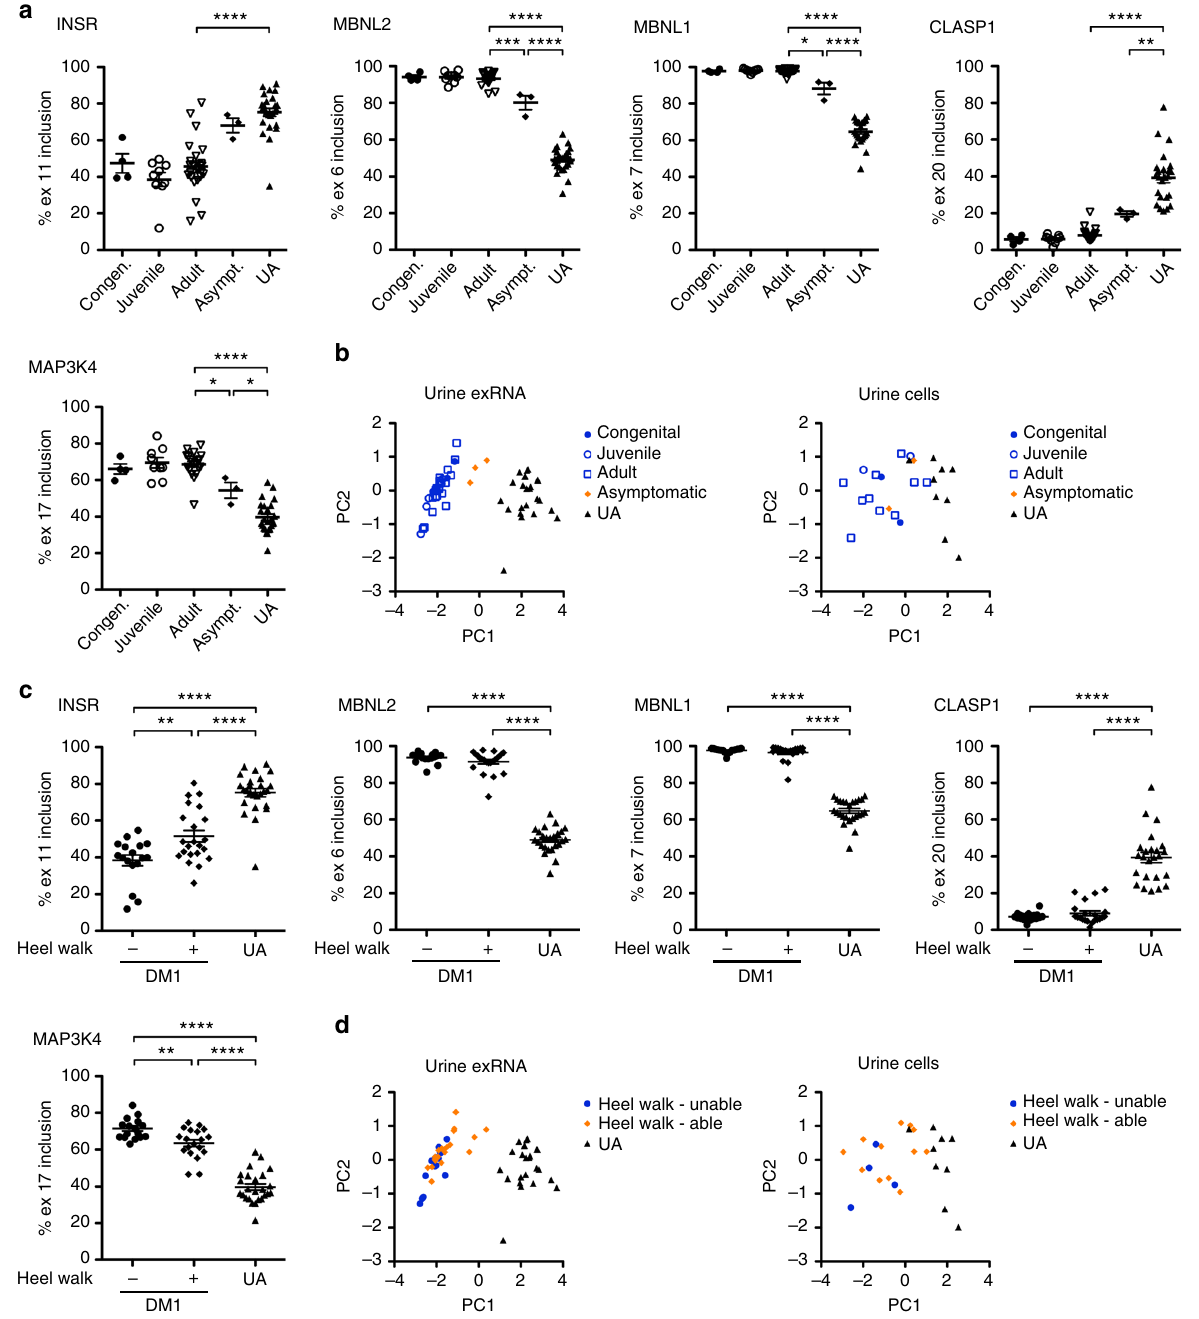
Fig. 9 Urine exRNA alternative splicing and composite biomarker scores as a function of symptoms. a ddPCR quanti fi cation of INSR , MBNL2 , MBNL1 , CLASP1 , and MAP3K4 alternative splicing in urine exRNA of congenital ( N = 4 or 5), juvenile-onset ( N = 6), adult-onset ( N = 22 to 24), and asymptomatic adult ( N = 3) DM1 patients, and in adult UA controls ( N = 25 or 26). **** P < 0.0001 (all fi ve transcripts, adult-onset vs. UA) and ( MBNL2 and MBNL1 , asymptomatic vs. UA,); *** mean difference 13.1, 95% CI of difference 4.3 – 22.0 ( MBNL2 , adult-onset vs. asymptomatic); ** mean difference 19.9, 95% CI of difference 3.5 – 36.3 ( CLASP1 , asymptomatic vs. UA); * mean difference 9.6, 95% CI of difference 1.5 – 17.6 ( MBNL1 , adult-onset vs. asymptomatic), mean difference 14.2, 95% CI of difference 0.01 – 28.4 ( MAP3K4 , adult-onset vs. asymptomatic), and mean difference 14.7, 95% CI of difference 0.6 – 28.7 ( MAP3K4 , asymptomatic vs. UA); one-way ANOVA. b Composite biomarker scores generated by principal component analysis of ddPCR splicing measurements in urine exRNA (left) and urine cells (right) displayed as a function of symptom onset. See Supplementary Fig. 9 for splicing quanti fi cation of each transcript in urine cells. c ddPCR quanti fi cation of INSR , MBNL2 , MBNL1 , CLASP1 , and MAP3K4 alternative splicing in urine exRNA of DM1 patients who were able to walk at least fi ve steps on their heels while maintaining ankle dorsi fl exion (a functional measure of ankle strength) ( “ + ” ; N = 19 – 22), and DM1 patients who were unable ( “ − ” ; N = 17). **** P < 0.0001 (all fi ve transcripts, DM1-Unable vs. UA, and DM1-Able vs. UA); ** mean difference 13.2, 95% CI of difference 3.1 – 23.2 ( INSR , DM1-Unable vs. DM1-Able), and mean difference 8.0, 95% CI of difference 1.7 – 14.4 ( MAP3K4 , DM1-Unable vs. DM1- Able); one-way ANOVA. d Composite biomarker scores for urine exRNA (left) and urine cells (right) displayed as a function of the ability to heel walk. All error bars indicate mean ±